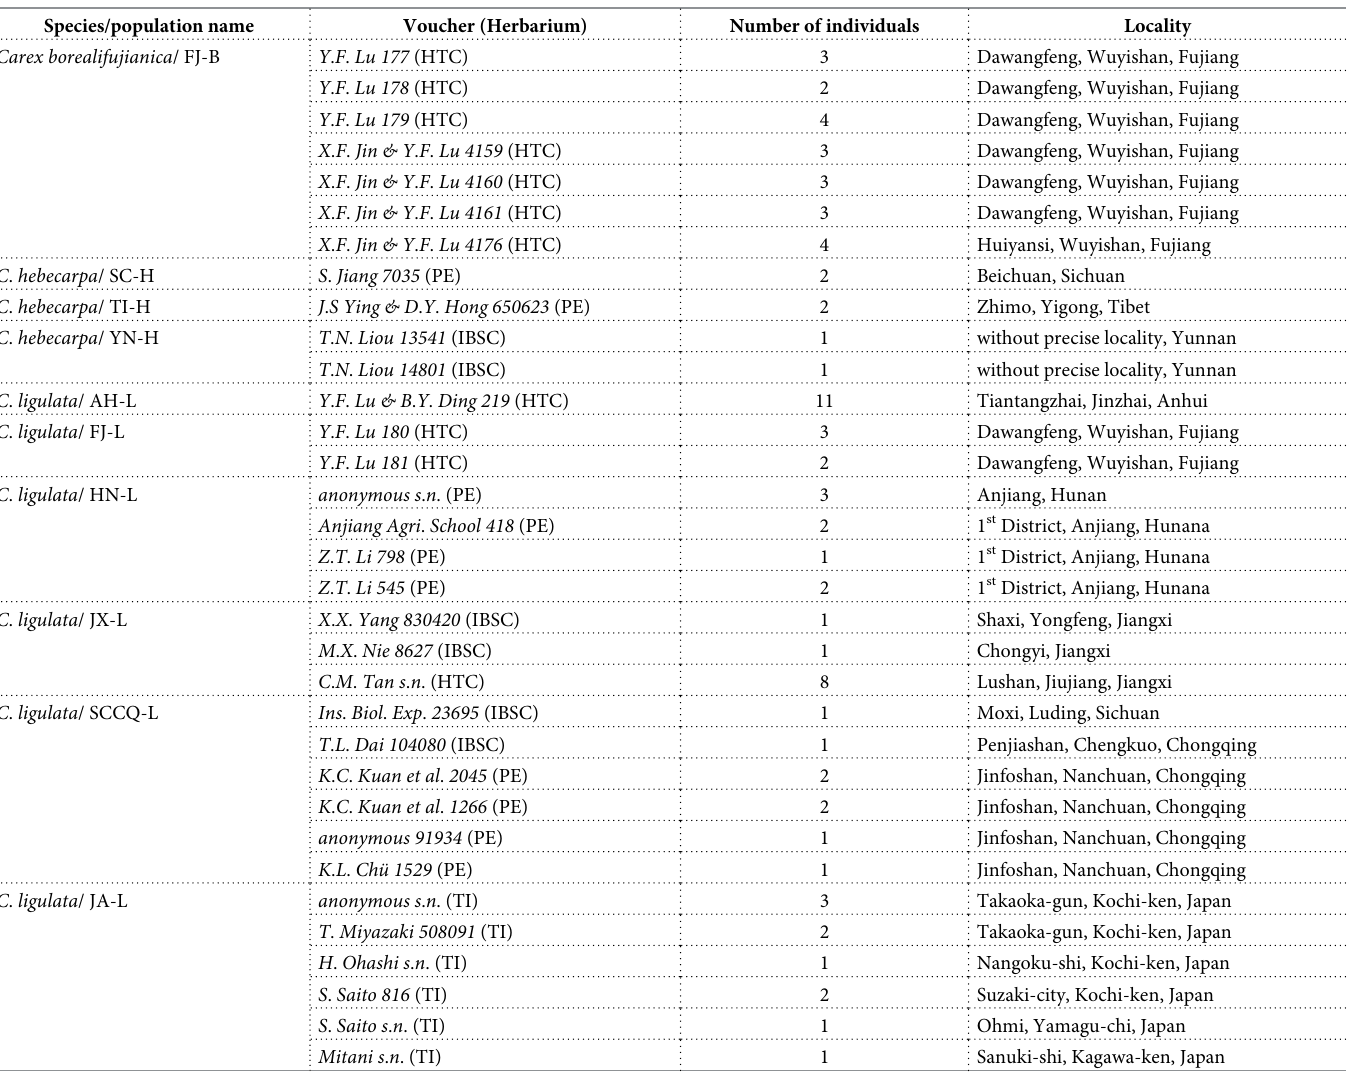
Table 2. Collection information of ten populations used to morphological